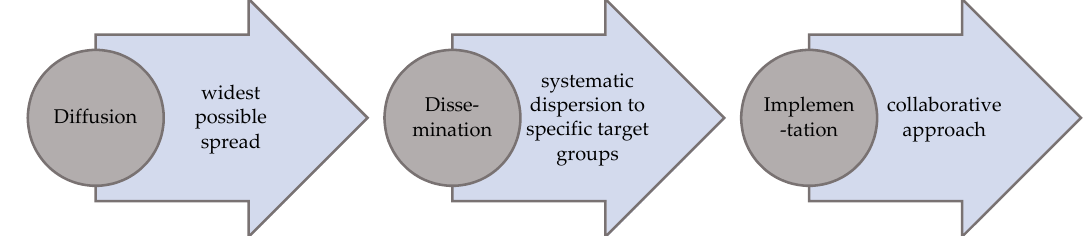
Figure 1. Process of implementing the National Action Plan Health Literacy in Germany.